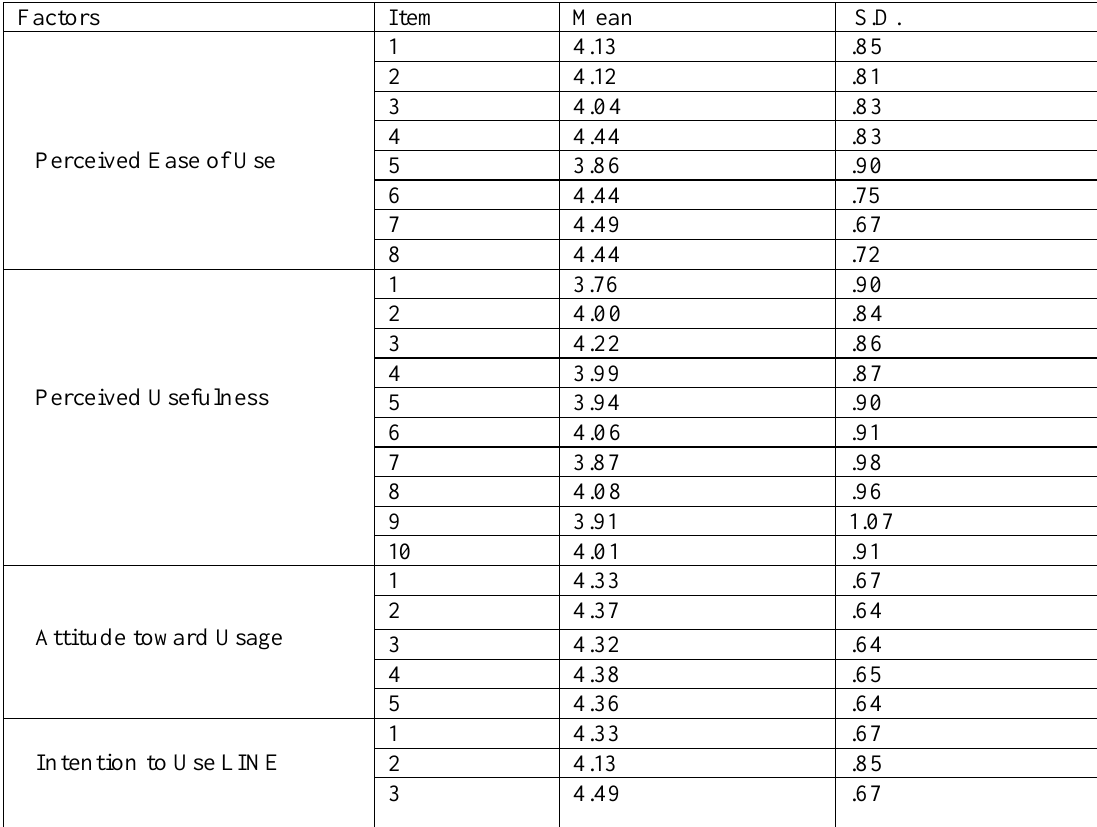
Mean and Standard Deviation of Factors